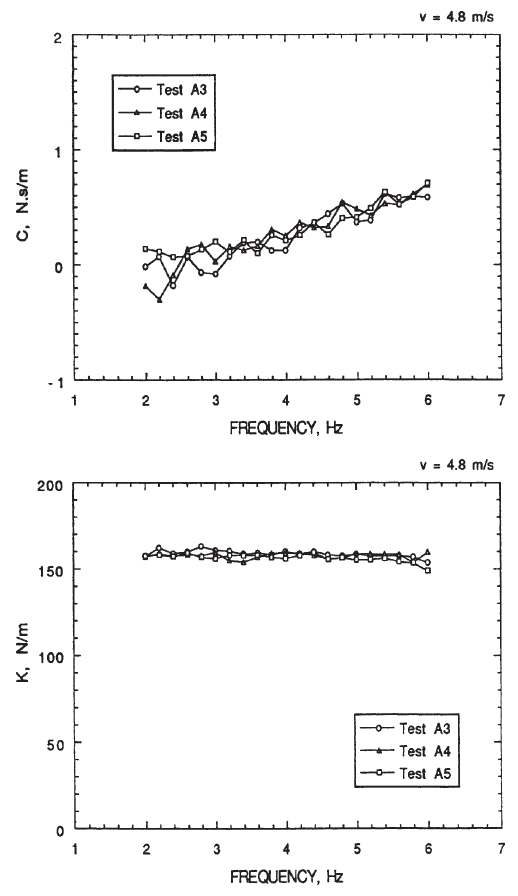
Fig. 7. Magnetic damping and stiffness as a function of excitation frequency for tests A3–A5, at 4.8